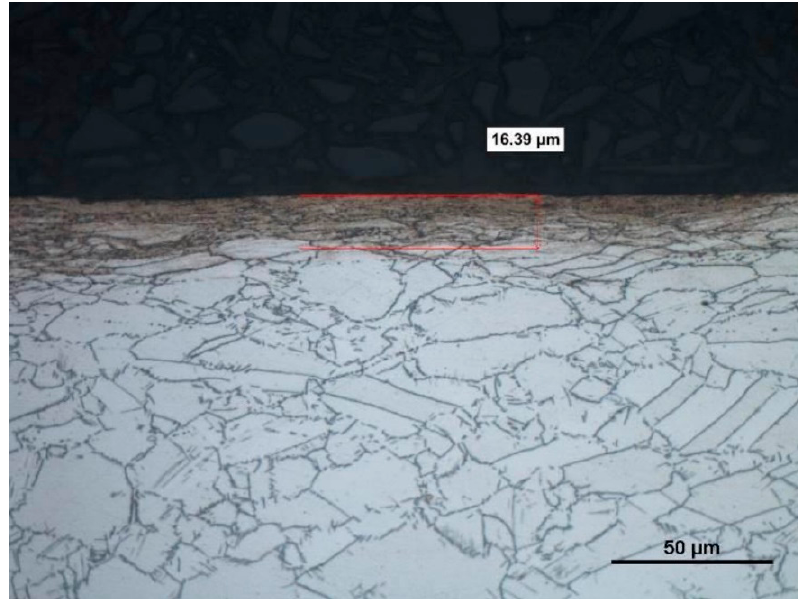
Figure 29. A view of a microsection after longitudinal turning without cooling and after etching.